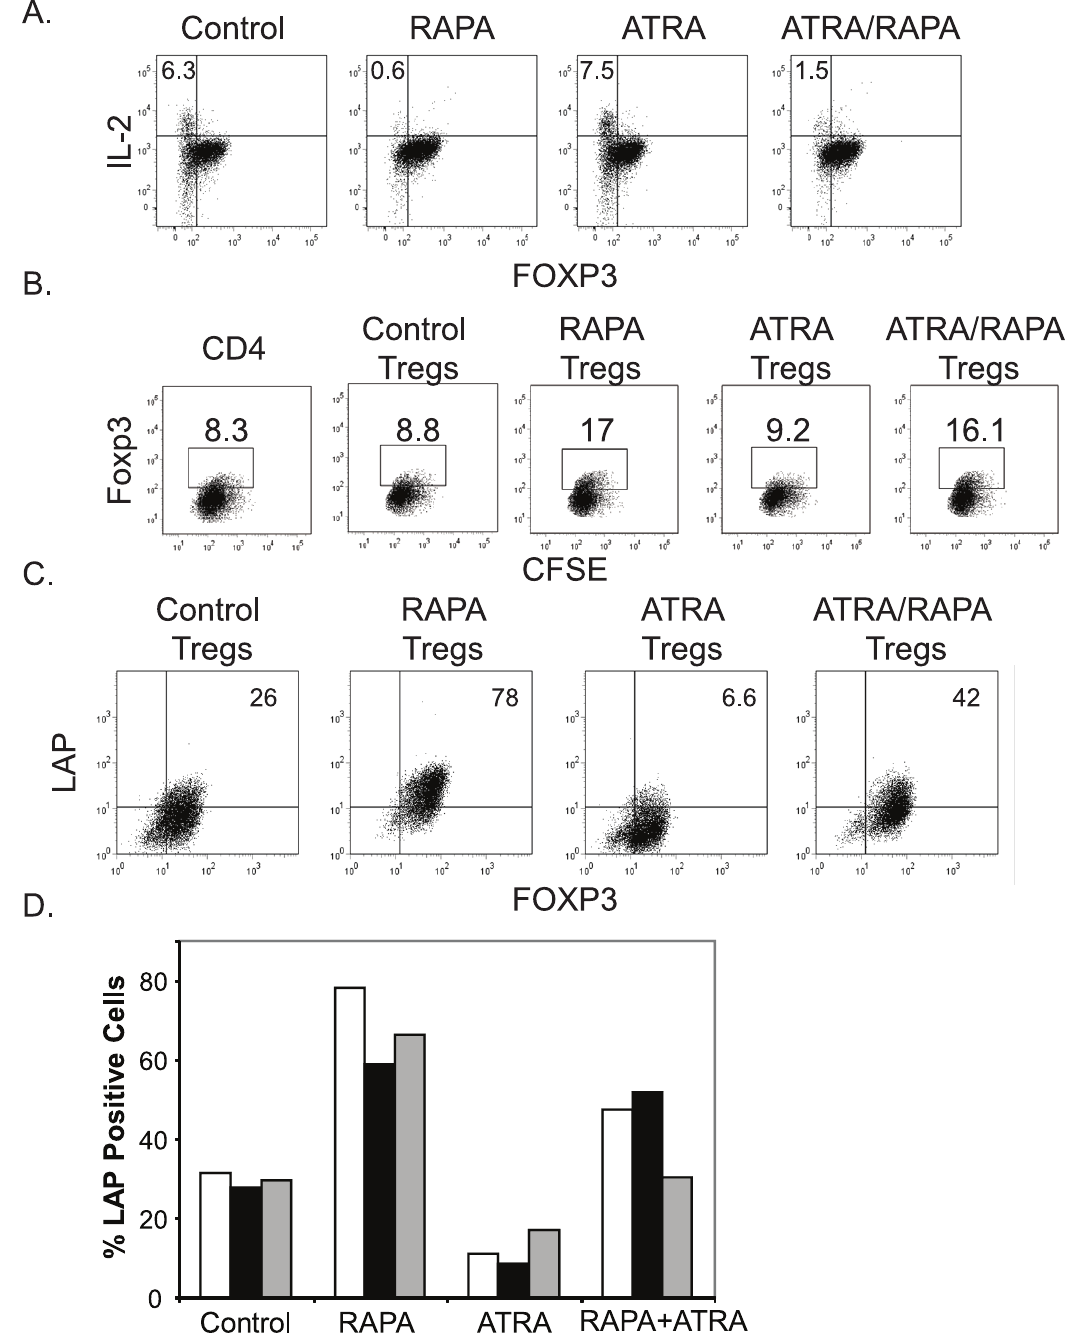
Figure 4. Tregs expanded with RAPA, but not ATRA, induce infectious tolerance. A . Enriched Tregs were expanded in the presence of the indicated compounds. At the end of the culture period (Day 15), the cells were stimulated with PMA + ionomycin for 4 hrs and intracellular IL-2 and FOXP3 expression were analyzed by flow cytometry. B . CFSE labeled FOXP3-negative CD4 T cells were activated with anti-CD3 Ab coated beads and mixed 1:1 with 2 day activated Tregs cultured with the indicated compounds. After 3 days of co-culture, cells were analyzed for FOXP3 expression by flow cytometry; the CFSE labeled cells are displayed. C . and D . Enriched Tregs were activated and expanded using the indicated culture conditions and expression of the Latency Associated Peptide (LAP) was determined after 4 days of culture by flow cytometry from a representative single donor ( C .). The composite data from multiple (3) donors is portrayed in D .